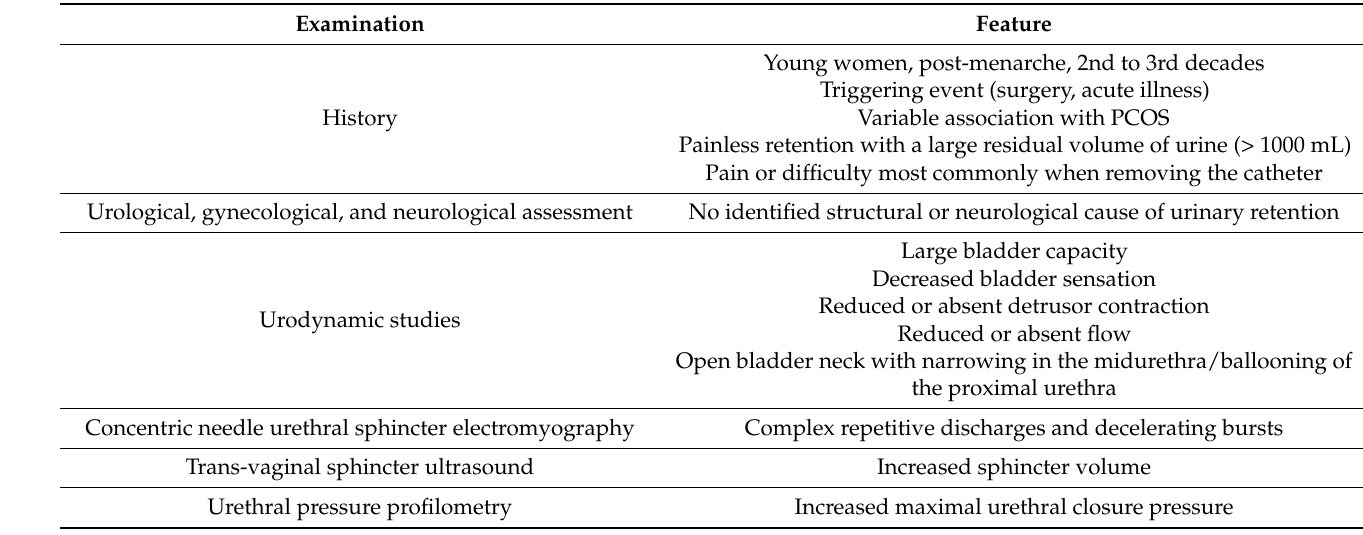
Table 2. Clinical features of Fowler’s syndrome